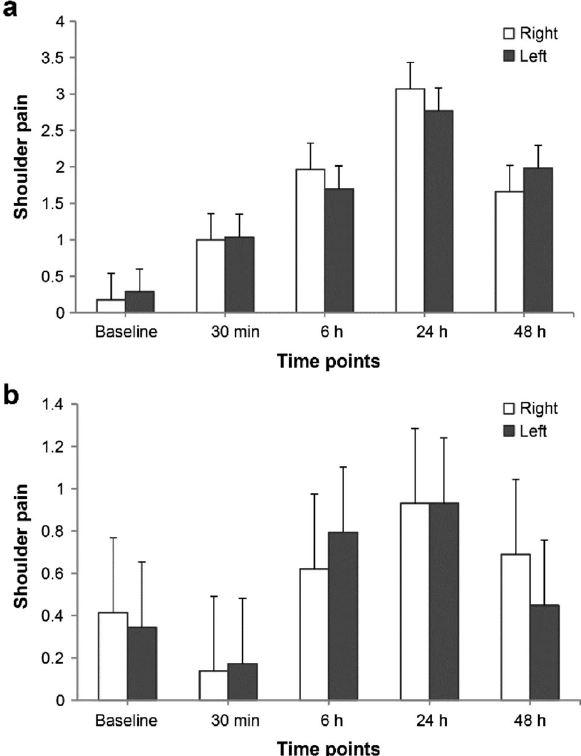
Figure 4. Comparison between right and left shoulder pain in control group ( a ) and patch group ( b ). Values were expressed as mean ± standard error. Baseline before anesthesia induction, 30 min 30 min after surgery, 6 h 6 h after surgery, 24 h 24 h after surgery, 48 h 48 h after surgery.